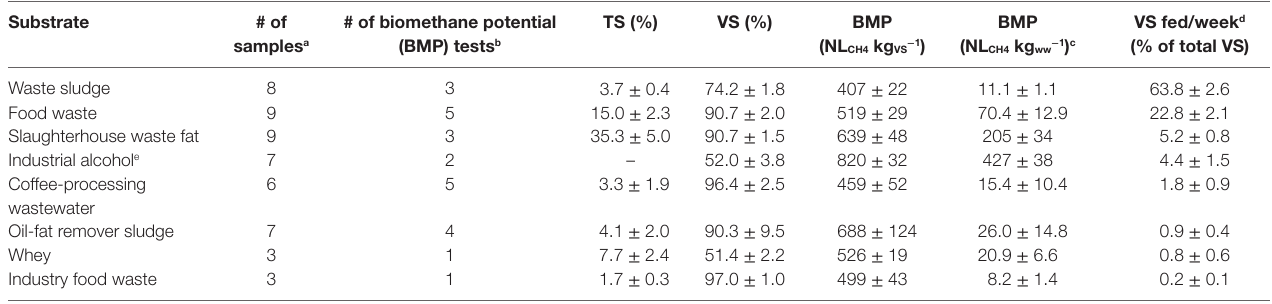
TaBle 2 | Characteristics of substrates that were co-digested at the wastewater treatment plant Bern. substrate # of samples